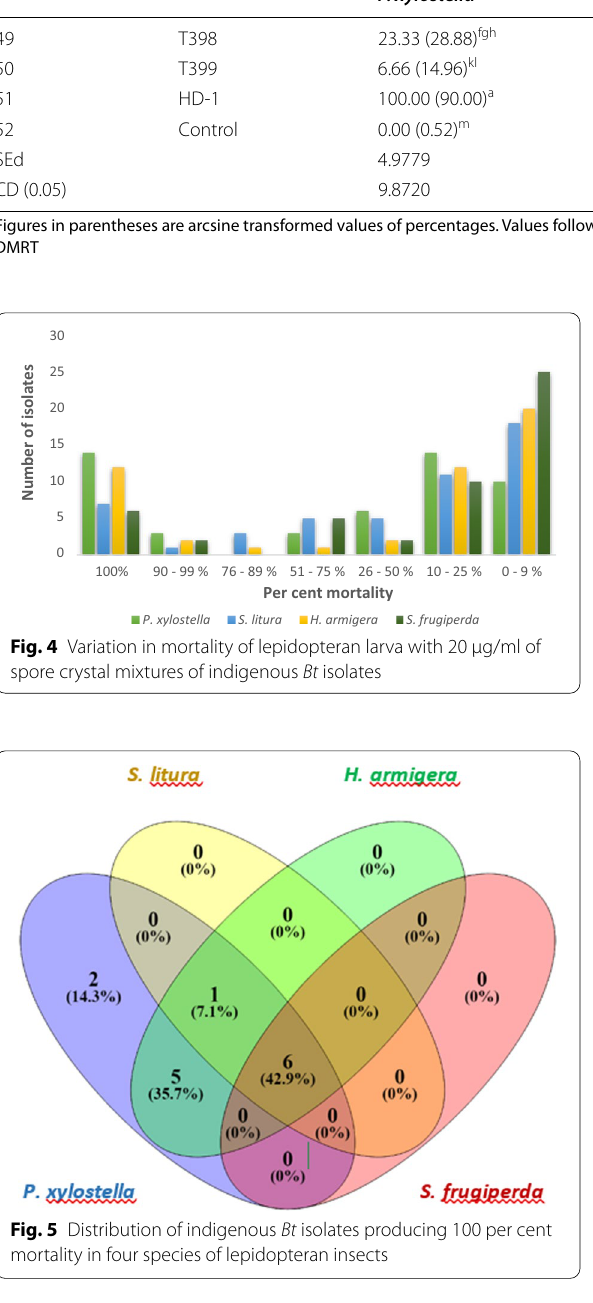
one species of insect. Similar results were reported ear- lier, and they found spore crystal mixtures of Bt isolates able to cause 100% mortality in P. xylostella (Navya et al. 2021), H. armigera (Lone et al. 2017), S. litura (Nayan- ganesh et al. 2018) and S. frugiperda (Karuppaiyan et al.